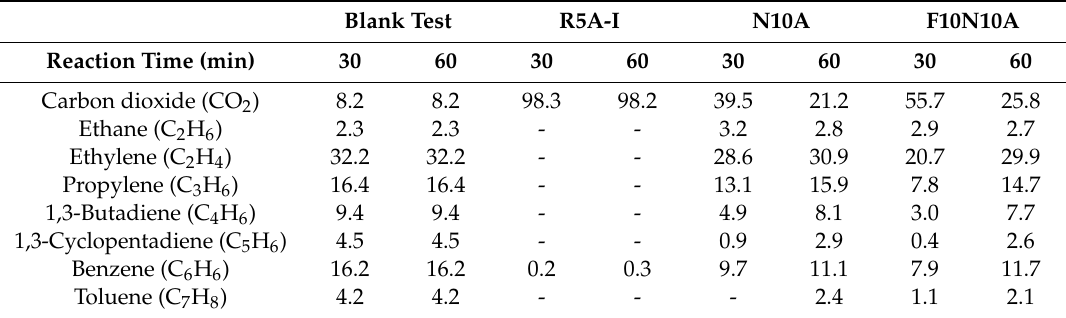
Table 1. Data obtained from the GC-MS of the blank test, R5A-I, N10A, and F10N10A after 30-minute and 60-minute reactions at the DHM fuel.